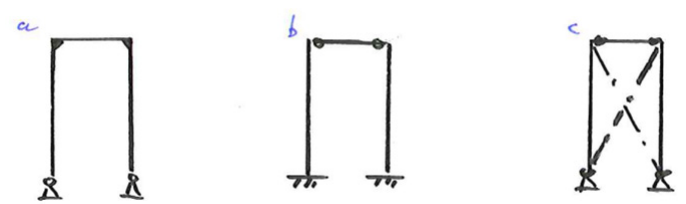
Fig. 8 Options for structure of wings: a = portal, b = clamped columns, c = bracings.